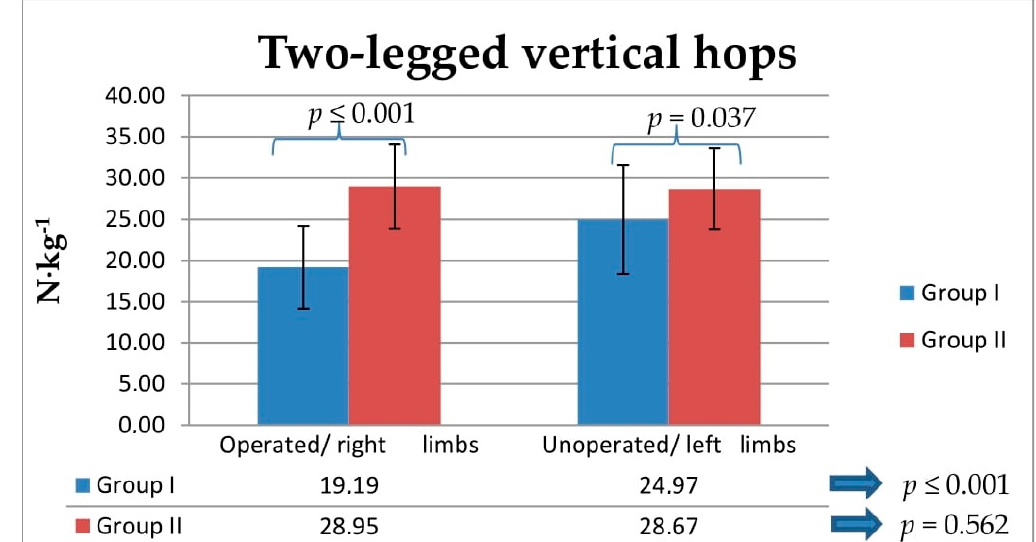
Figure 3. Comparison of the between-group and intragroup values of the vertical component of ground reaction forces during two-legged vertical hops, normalized for body mass, N · kg − 1 , in Group I and Group II. Statistical significance level ( p ).